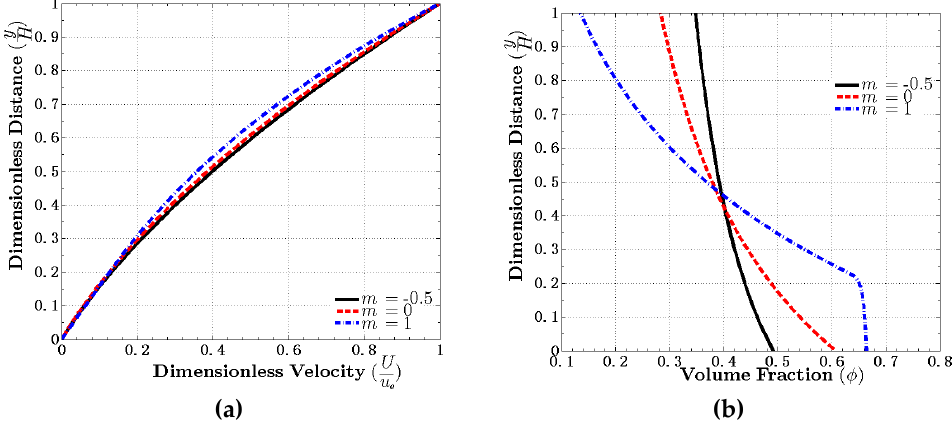
Figure 6. The effect of 𝑚 on the velocity profile ( a ) and the volume fraction profile ( b ), when 𝑅 = 1 , (2𝑀 (cid:2869) + 𝑀 (cid:2870) ) = 1 , 𝐵 (cid:3043) = −1 , 𝐵 (cid:3045) = −10 , 𝜙 (cid:3030) = 0.68 , 𝑆 = 100 , 𝐹𝑟 = 0.5 , 𝑁 = 0.4 .